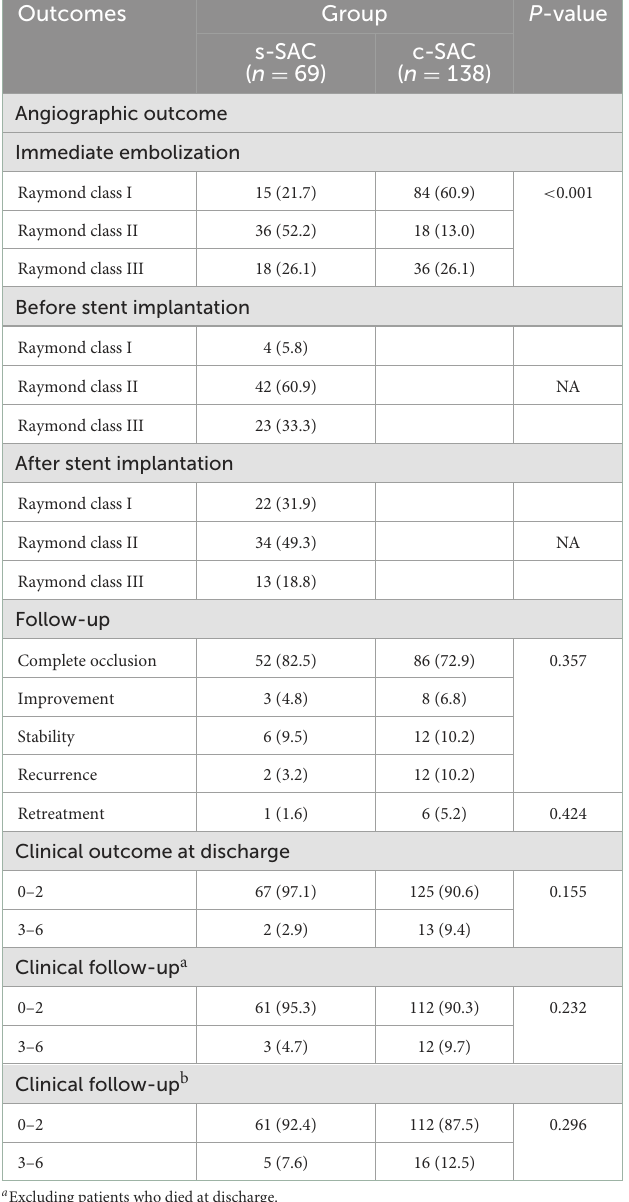
between the two groups ( p = 0.272). Our study results may